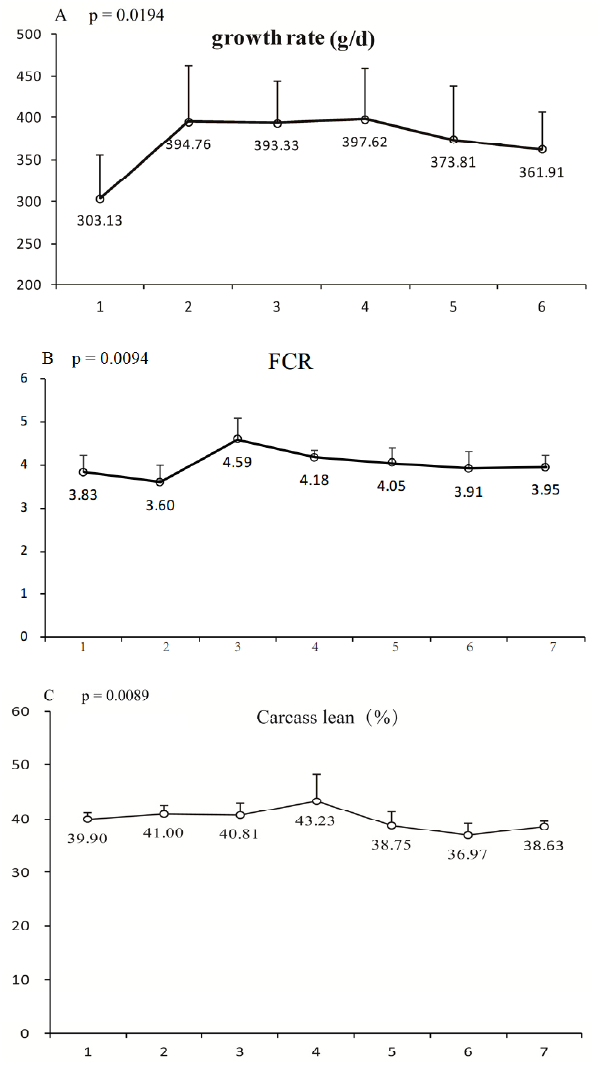
Figure 2. Growth rate, feed conversion rate (FCR) and carcass lean percentage of Liangshan pig. (A) growth rate (B) FCR and (C) carcass lean percentage. x-coordinate 1 to 7 mean the slaughter weight